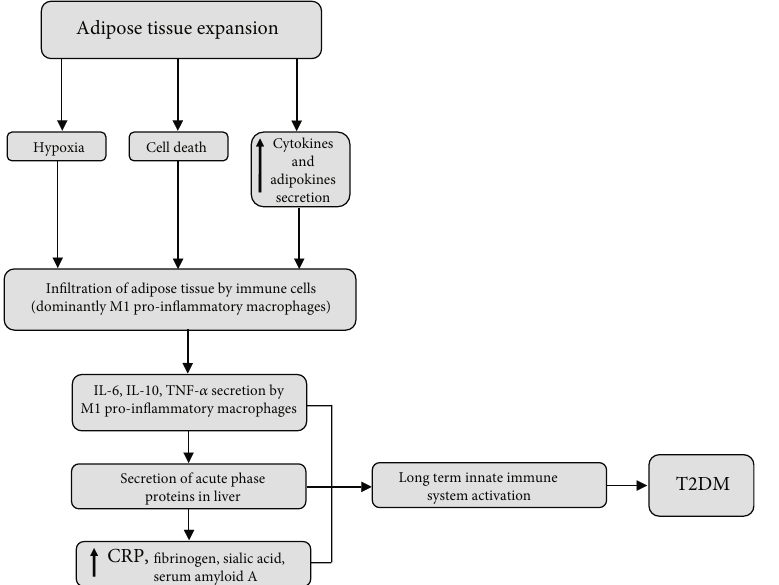
Figure 2: T2DM development as a result of chronic low-grade in fl ammation. CRP: C-reactive protein; IL-6: interleukin 6; IL-10: interleukin 10; i.p.: intraperitoneal; TNF- α : tumor necrosis factor α ; T2DM: type 2 diabetes